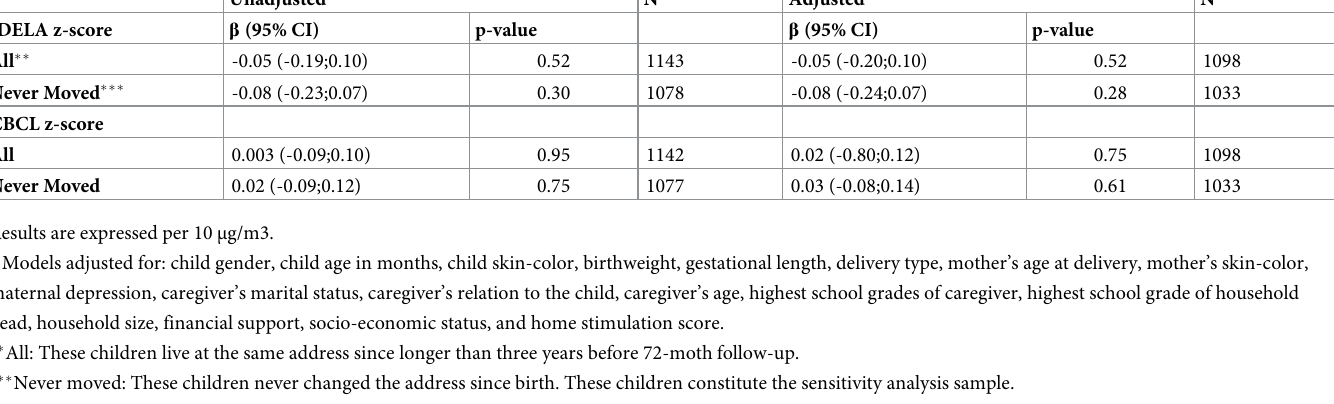
Table 2. Association of NO 2 exposure as continuous [ μ g/m 3 ] with IDELA (z-score) and with CBCL (z-score), unadjusted and adjusted � models. Unadjusted